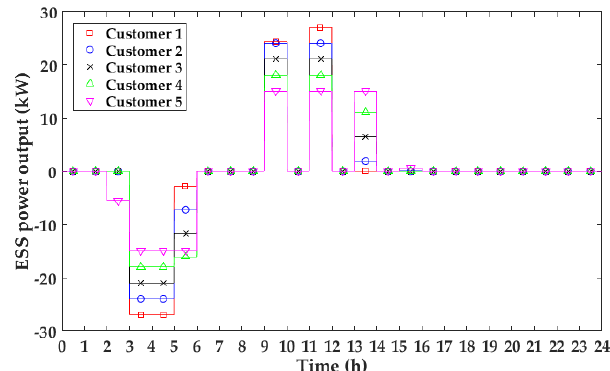
Figure 12. ESS charging schedule in Case 2 on Day 2.